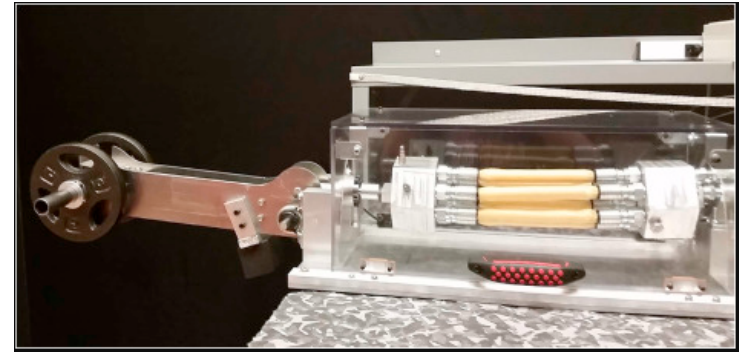
Figure 10. Example of a rigid-body robot arm using McKibben artificial muscle [122]. (Copyright 2018, Elsevier.)